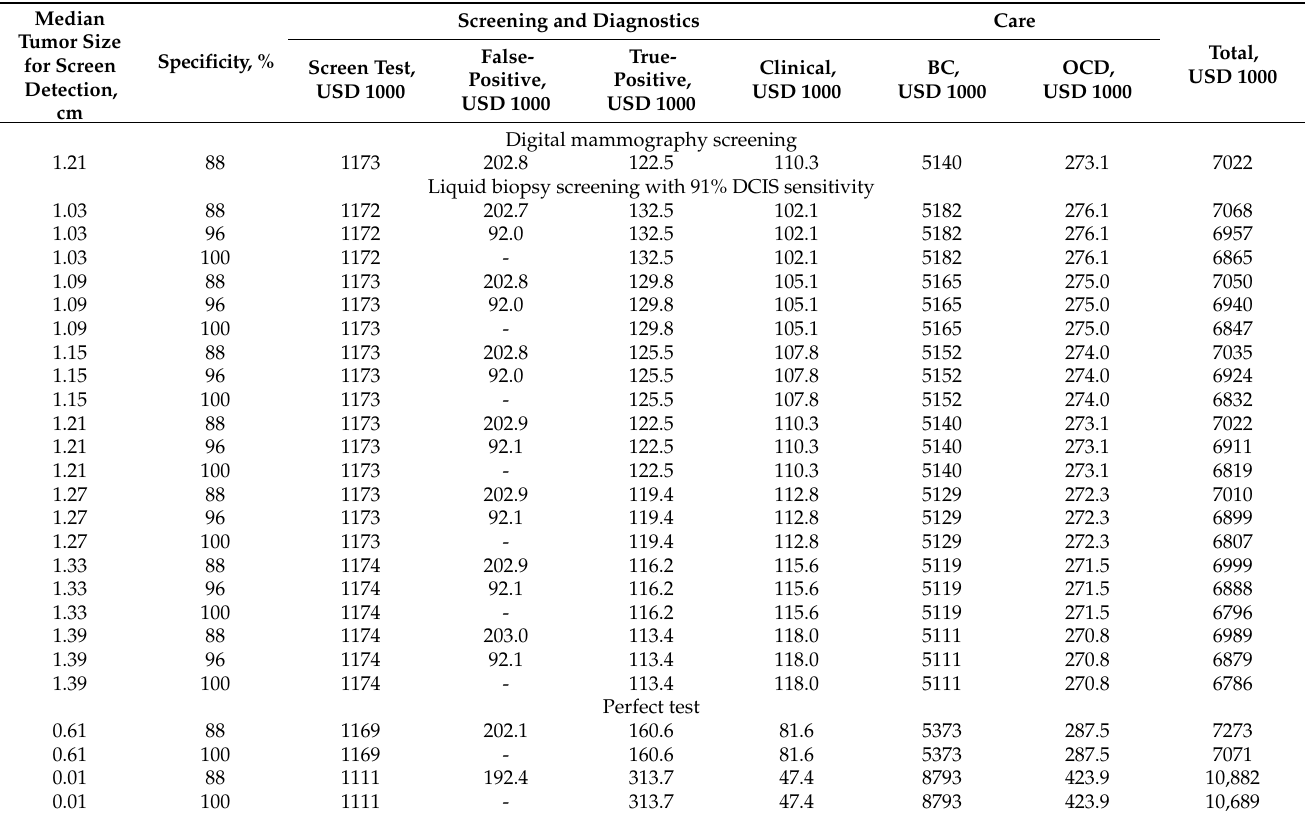
Table A2. Costs of breast cancer screening and care per 1000